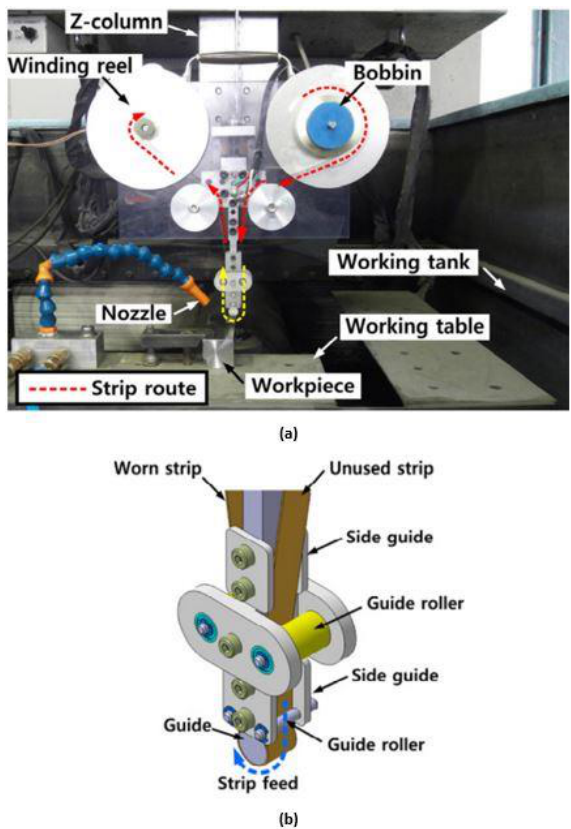
Figure 15. ( a ) Strip-EDM system; and ( b ) electrode guide [159].